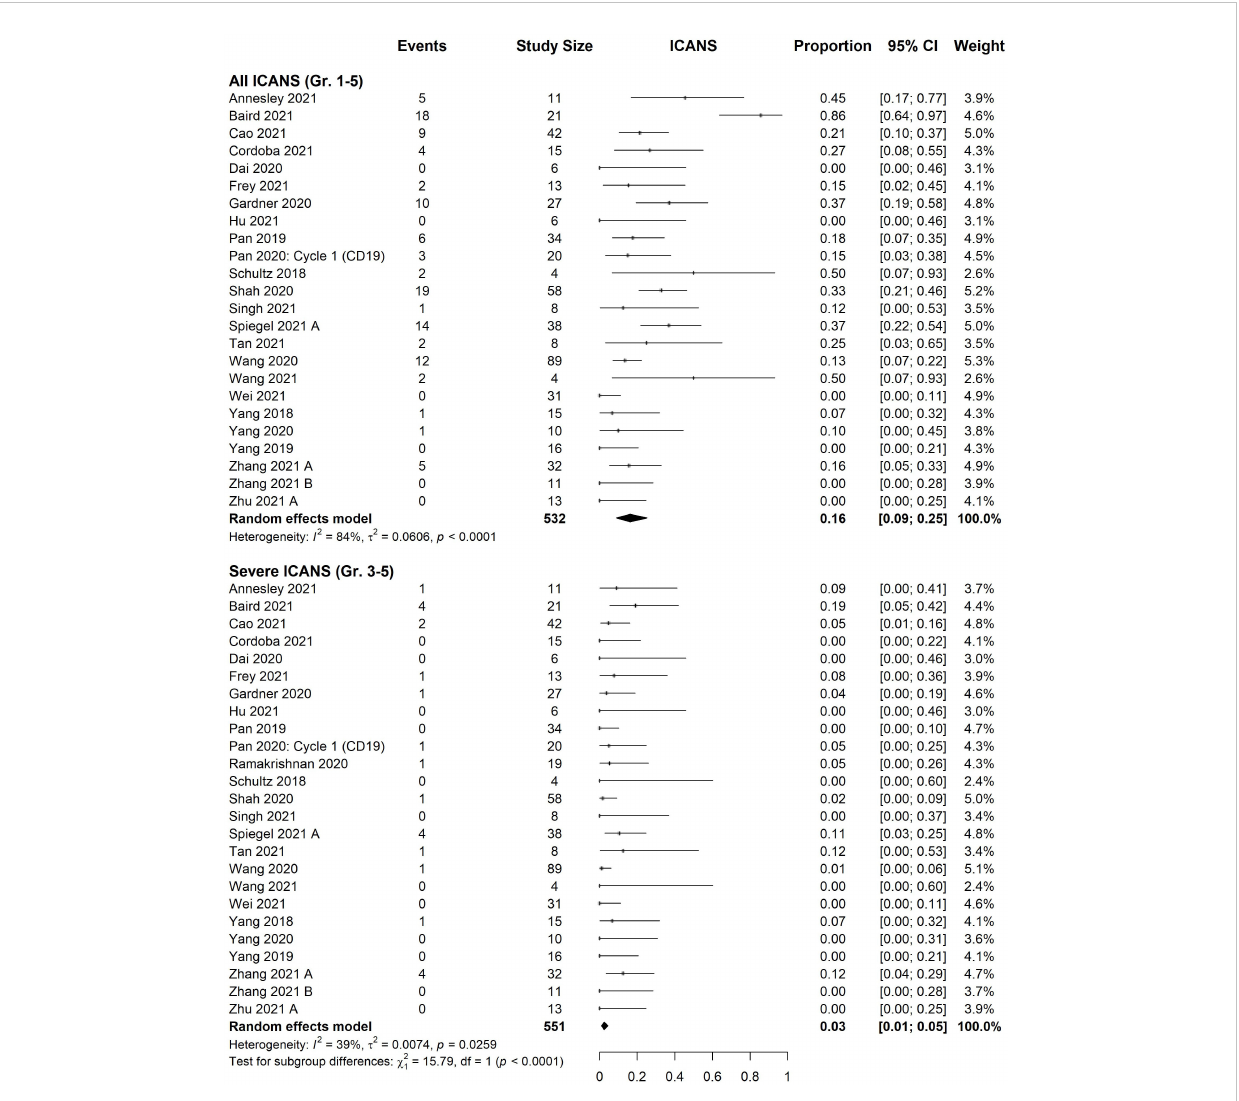
FIGURE 4 Forest plot of immune effector cell-associated neurotoxicity syndrome rate organized by severity. Pooled estimate of effect, black diamond, was calculated for both all grades (1-5) and severe grades (3-5). Pan 2020: cycle 1 (CD19) was excluded from analysis, although rates did not signi fi cantly differ from cycle 2 (3/20 all grades, 1/20